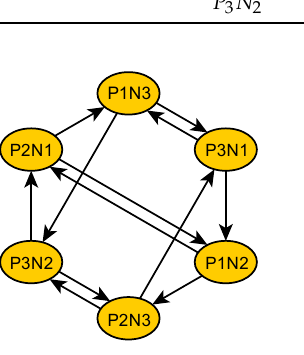
Figure 5. H graph of the 3-modules CHB-B2B in ISOP